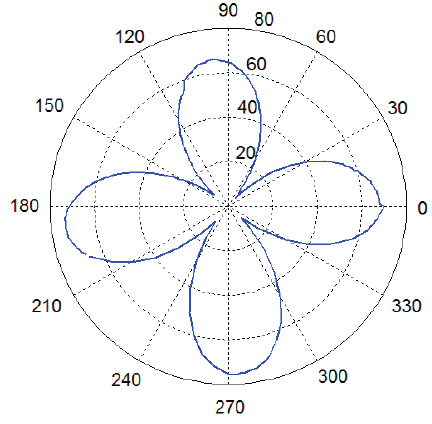
Figure7. Testing results of the vibration mode of the cylindrical resonator.